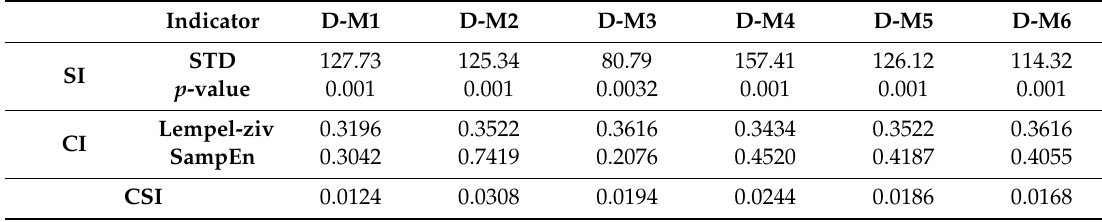
Table 2. Comprehensive selection indicator after